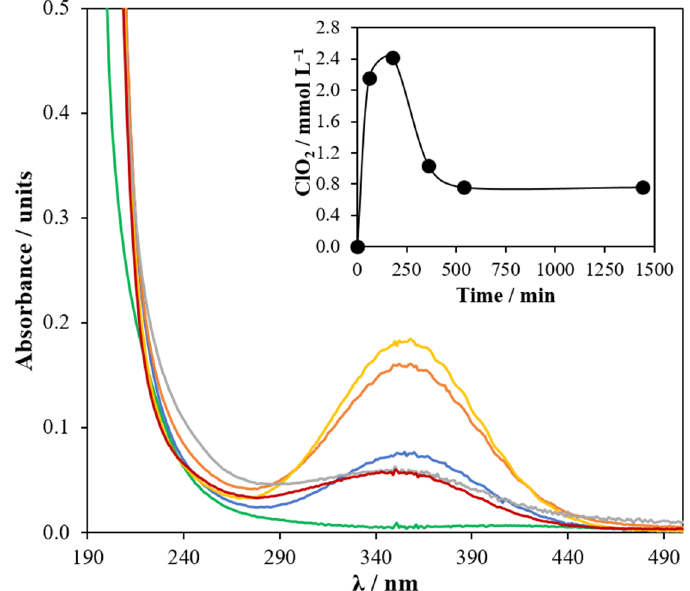
Figure 6. Changes in the UV-vis spectra during production of chlorine dioxide in the liquid reaction mixture from electrochemically generated hydrogen peroxide and chlorate in test EQI. The inset panel shows the concentration of chlorine dioxide produced in the system during the reaction. Legend: (—)